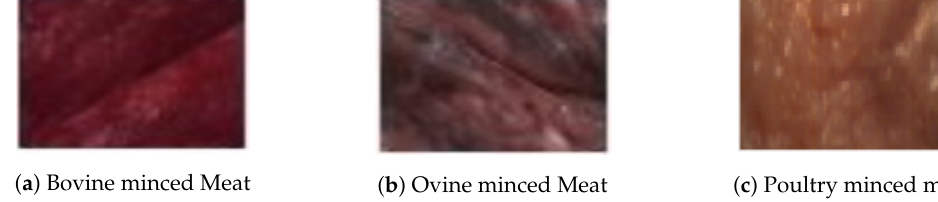
Figure 8. Color ROI representation of each minced meat type. ( a ) Bovine; ( b ) Ovine; ( c ) Poultry